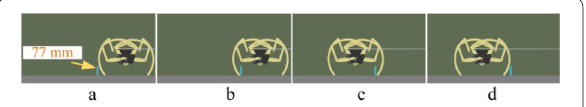
Figure 10 Walking and crossing obstacles